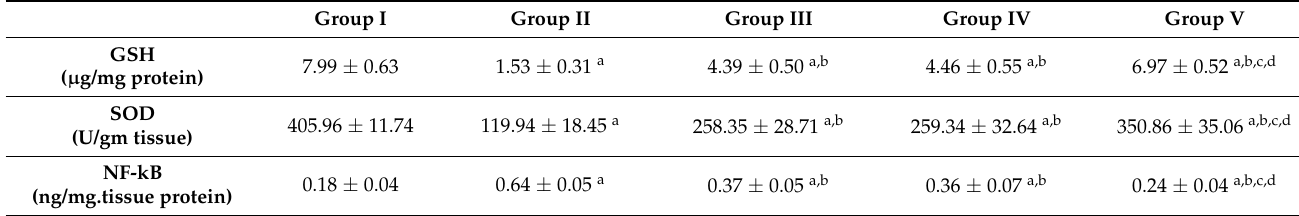
Table 2. Oxidative stress and inflammatory parameters.